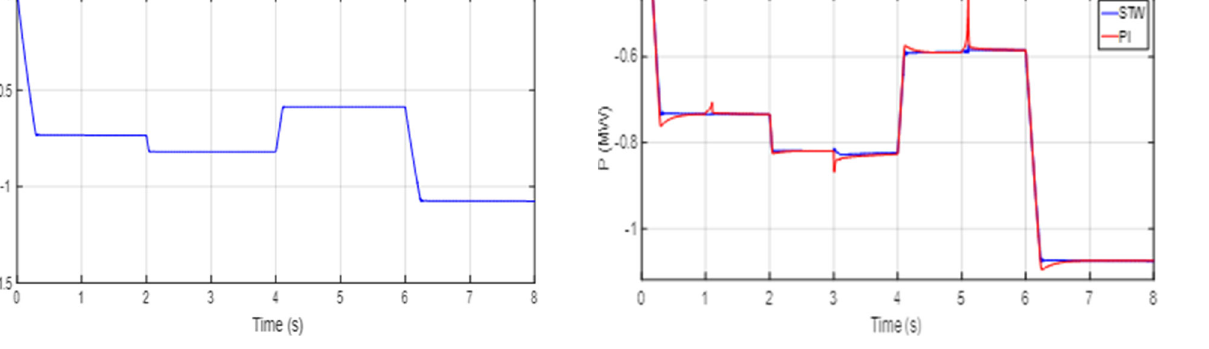
Fig. 21 DFIG stator active